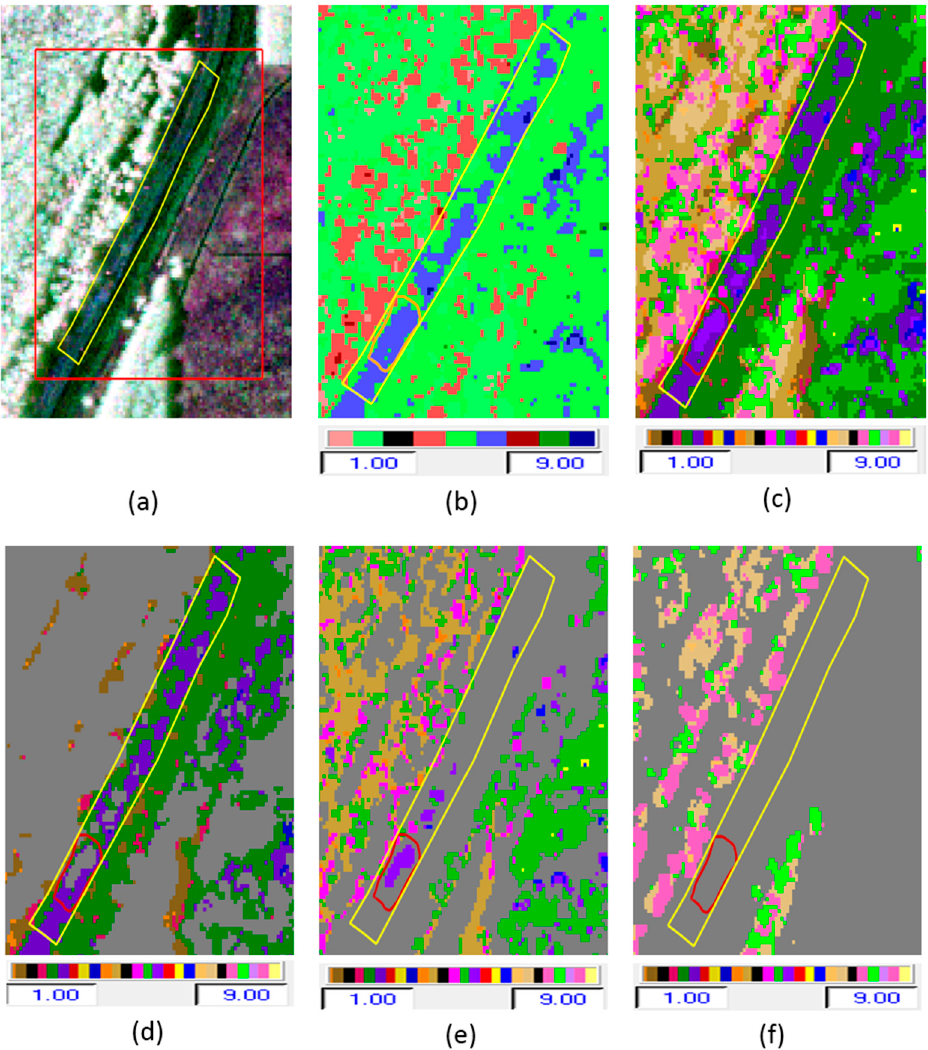
Figure 8. ( a – c ) Pauli RGB Image, H/ α classification, and H/ α / λ classification; ( d – f ) H/ α / λ 1 classification, H/ α / λ 2 classification, and H/ α / λ 3 classification. Table 2. Class values of segmented zones for the H/ α , H/ α / λ 1 , H/ α / λ 2 , and H/ α / λ 3 classifications using the H/ α segmentation plane for random media scattering.